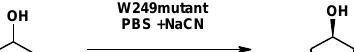
Figure 7. Continuous synthesis of ( S )-4-chloro-3-hydroxybutanenitrile ( S -CHBN) from 1,3-DCH and NaCN catalyzed by halohydrin dehalogenase (HheC).